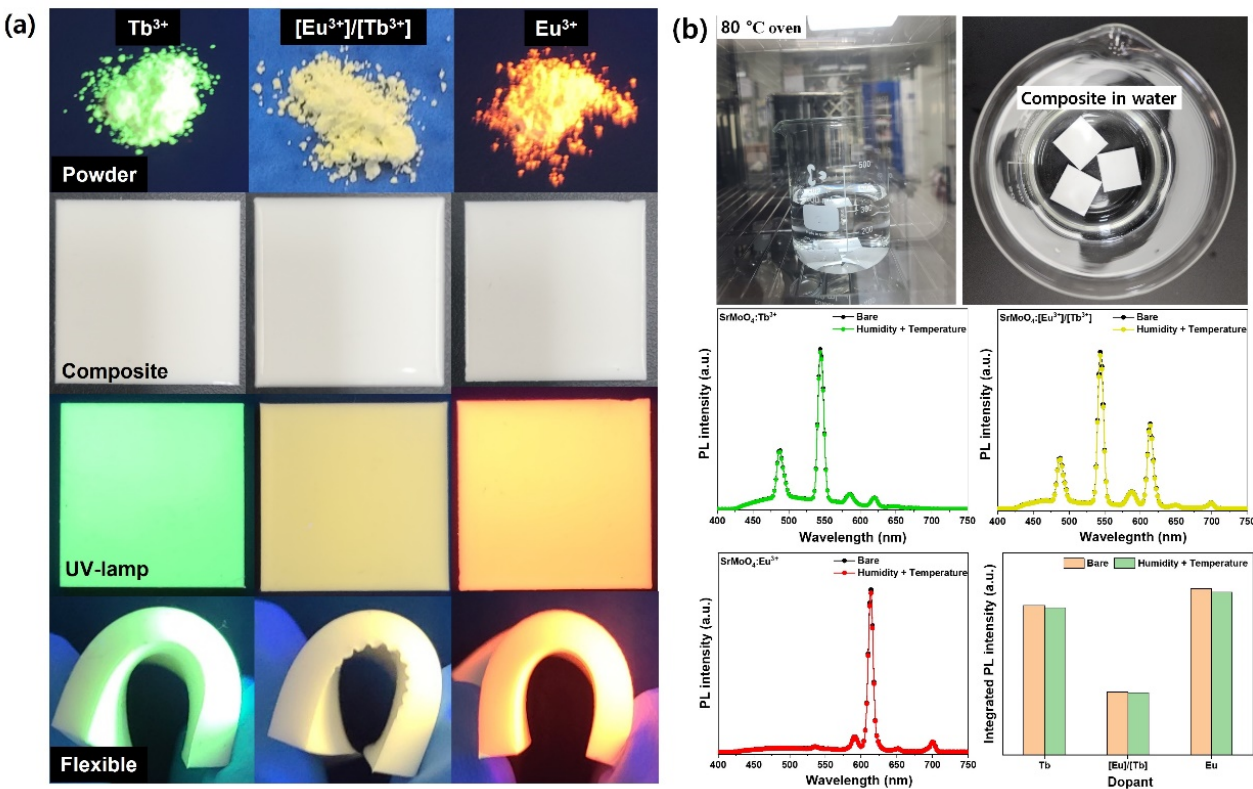
Figure 8. Images of ( a ) SrMoO 4 :RE 3+ phosphor flexible composite under daylight and UV-lamp and ( b ) resistance of the composite to temperature and humidity.